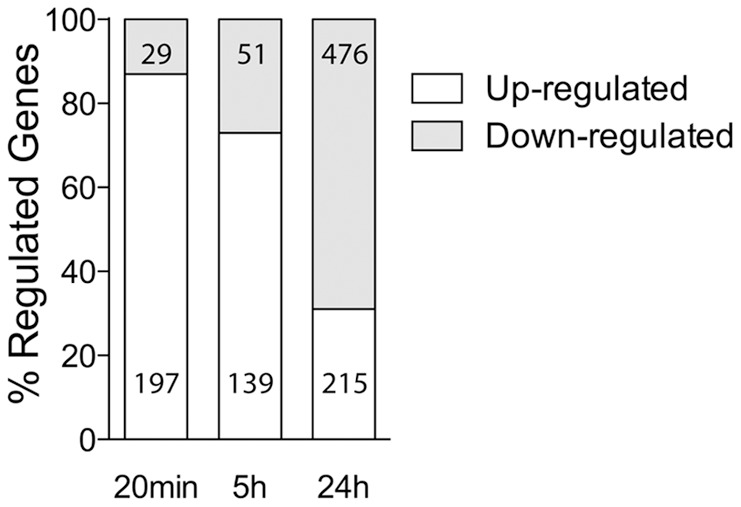
LTP-related gene expression 20 min, 5
h and 24
h post-LTP induction. Alterations in mRNA transcript number identified 20 min, 5 h and 24 h post-LTP, as detected using Affymetrix RAT 230 2.0 microarrays; note increase in proportion of downregulated genes at 24 h (dual selection criteria: fold change ≥1.15 or ≤0.85; p<0.05).